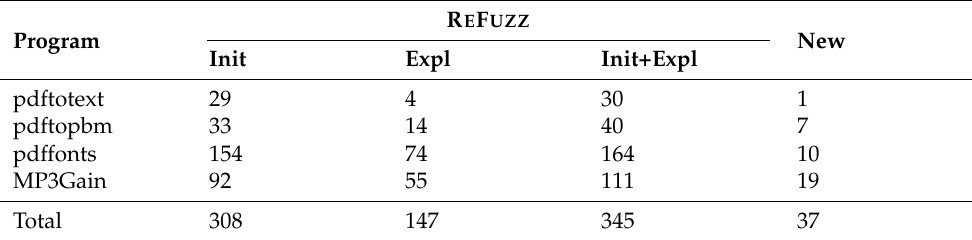
Table 3. Number of unique crashes (60 + 20).